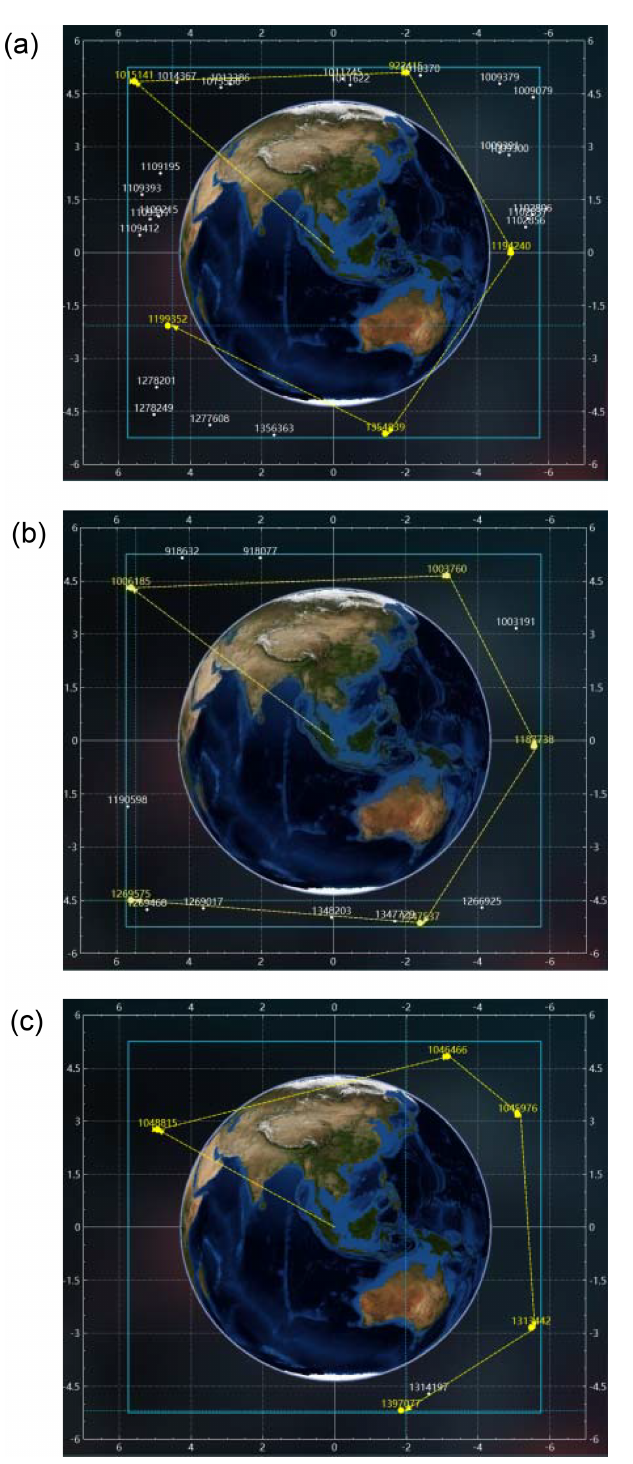
Figure 5. Examples of AGRI star selection results: panel (a) with a lot of stars, (b) with a reasonable number of stars and (c) with a few stars. Figure 6. Examples of GIIRS star selection results: panel (a) with